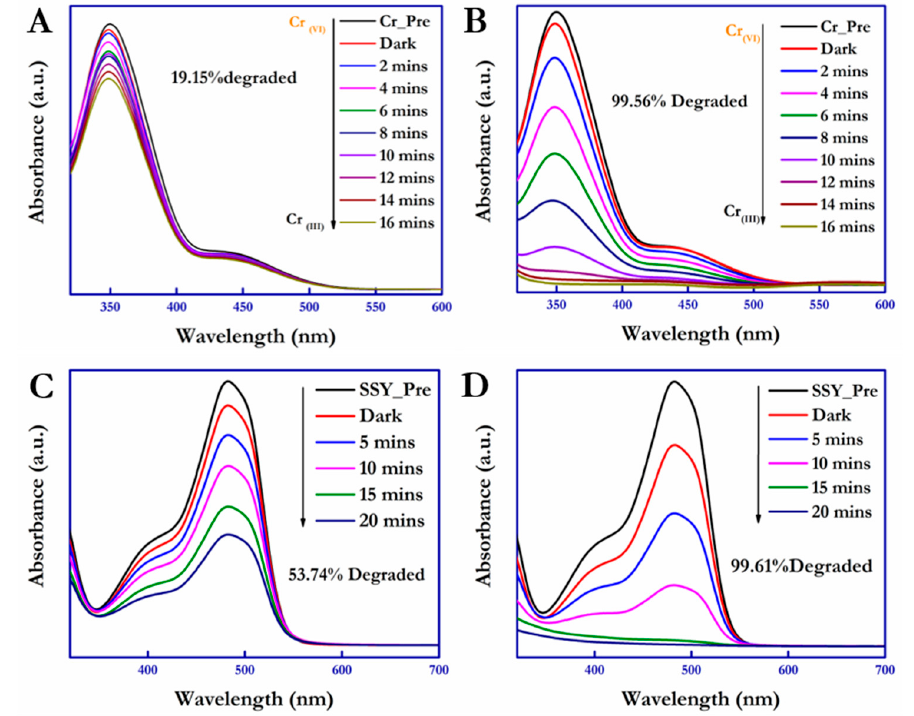
Figure 9. UV–Vis profiles for the photocatalytic reduction of Cr 6+ by g-C 3 N 4 ( A ) and g-C 3 N 4 –SO 3 H ( B ) and the photocatalytic oxidation of SSY by g-C 3 N 4 ( C ) and g-C 3 N 4 –SO 3 H ( D ).